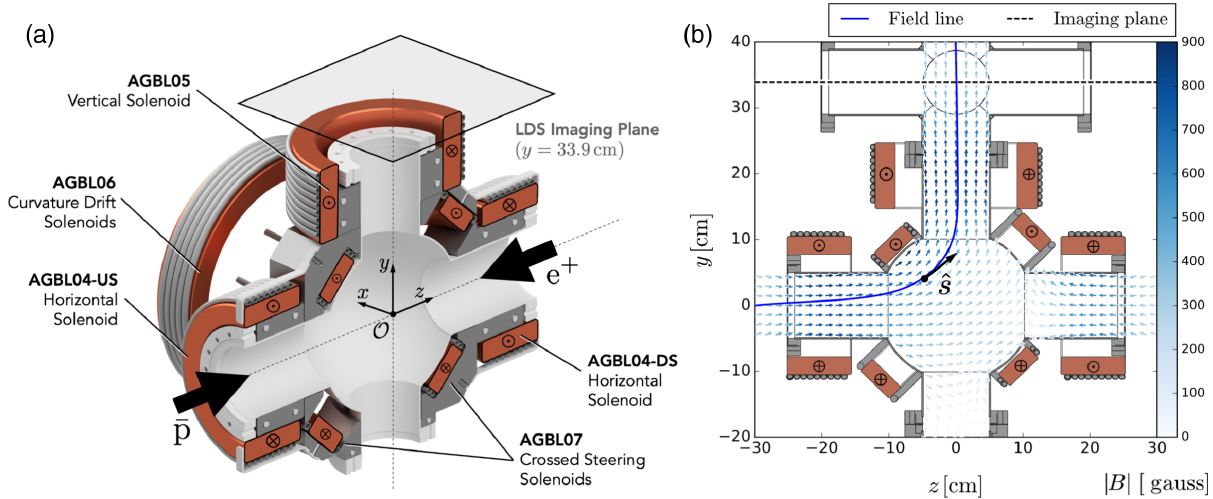
FIG. 7. (a) Simplified schematic showing a cross section of the interconnect. The magnet windings are highlighted in orange, while the UHV chamber, cooling circuits, and magnet support structures are shown in gray. One of the AGBL06 magnets is not visible in this cutaway view. Crosses (dots) indicate the current flowing into (out of) the shown cross section of each magnet. (b) Quiver plot showing the strength (color) and direction (arrow orientation) of the magnetic field within the midplane of the interconnect. The blue line shows a magnetic field line traced from the horizontal axis of the experiment, while the dashed line indicates the LDS imaging